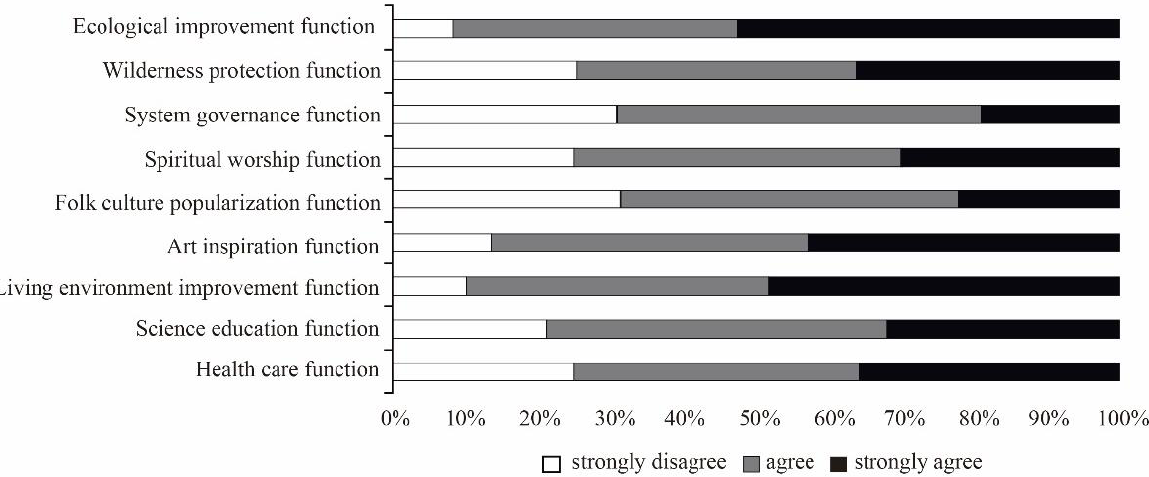
Figure 2. Proportion of community residents with different cognition degrees of cultural service functions.